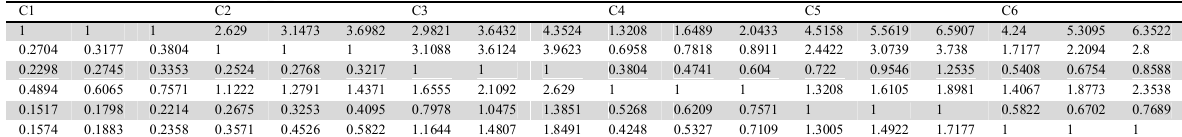
Matrix of Paired Comparison of Goals